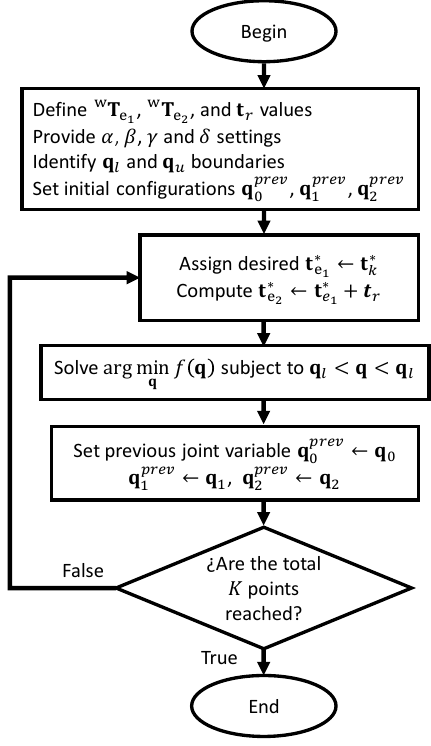
Figure 5. Coordinated trajectory tracking